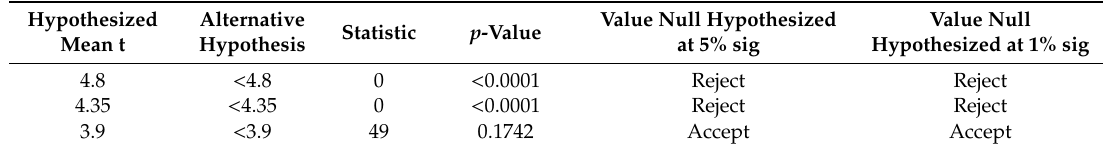
Table 9. Results of Wilcoxon test for Fa.